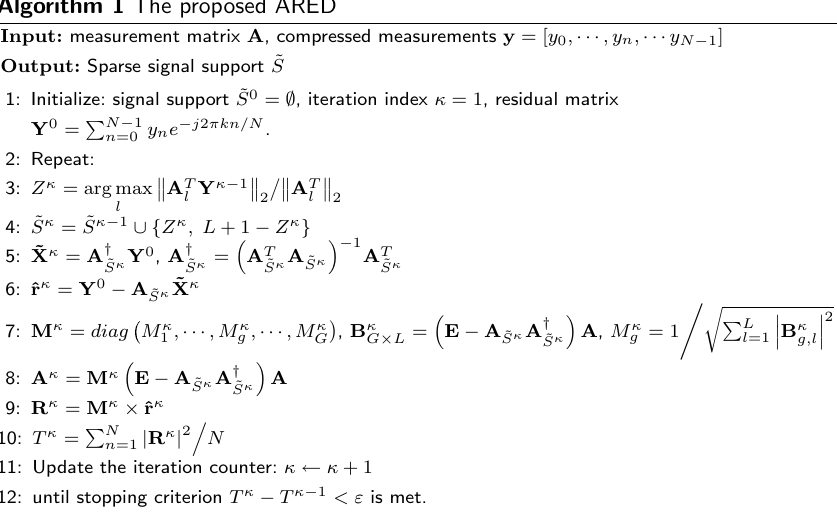
Algorithm 1 The proposed